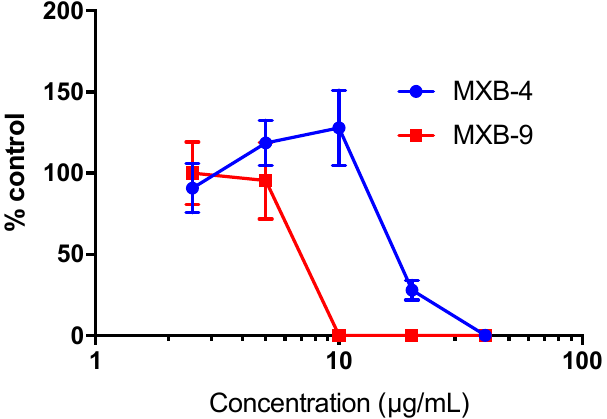
Figure 4. Antiviral activity against SARS-CoV-2. Virus was incubated with peptoids or PBS (control) for 1 h at 37 °C ( n = 3 per condition), prior to infecting Vero E6 cells. After 3 days, total plaques were counted. Data are expressed as percent of control-treated virus. Results shown are representative of two independent replicate experiments.